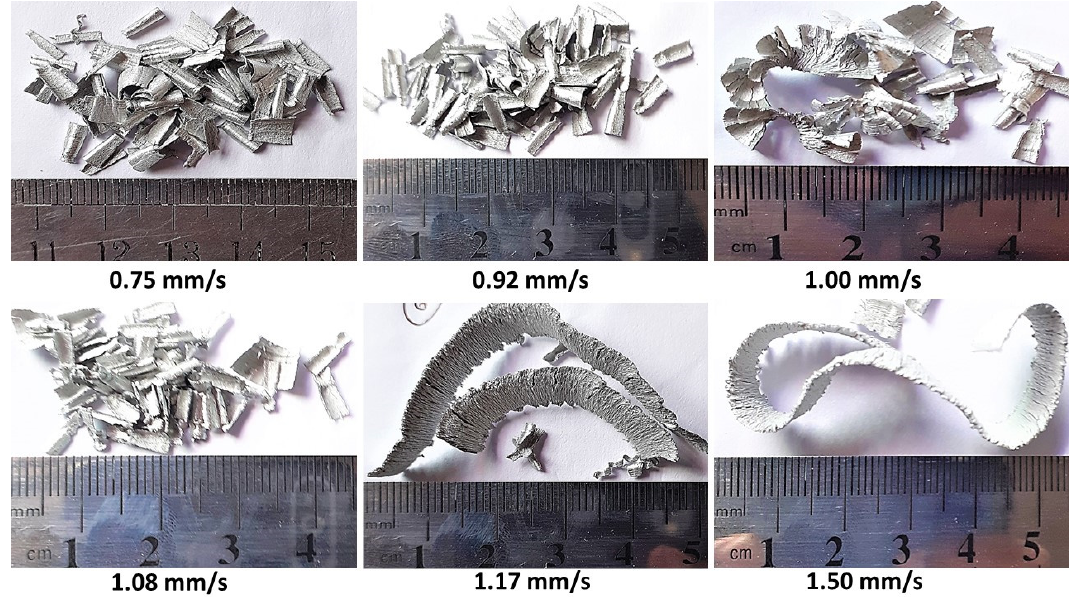
Figure 7. Effect of feed rate on Al alloy chip formed in conventional macro machining.